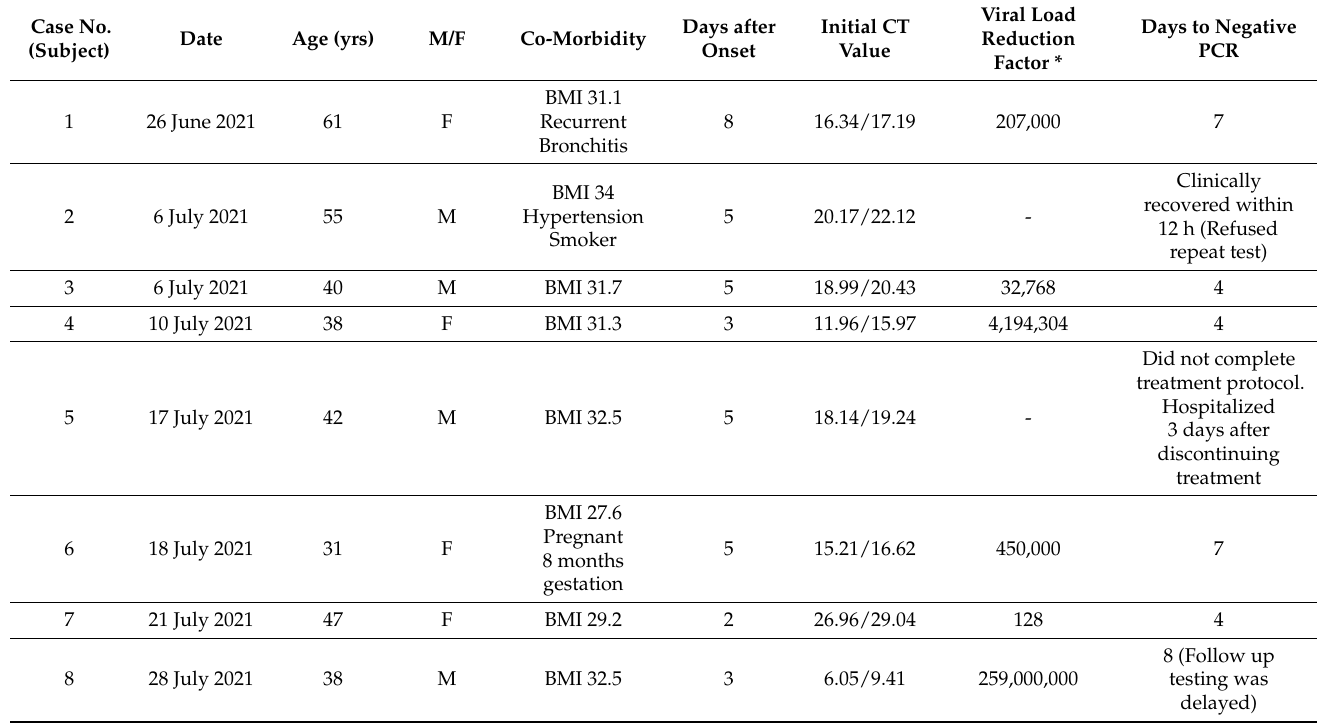
Table 6. Summary of the pilot study data and results. * Based on the difference in SARS gene initial CT value and 34 (threshold for a negative test result). Abbreviations: CT: cycle threshold; M: male; F: female; yrs: years; no.: number; PCR: polymerase chain reaction; BMI: body mass